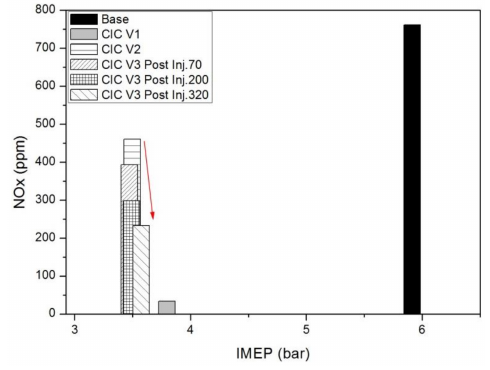
Figure 16. Comparison on IMEP versus NO x for different variable valve control strategies.